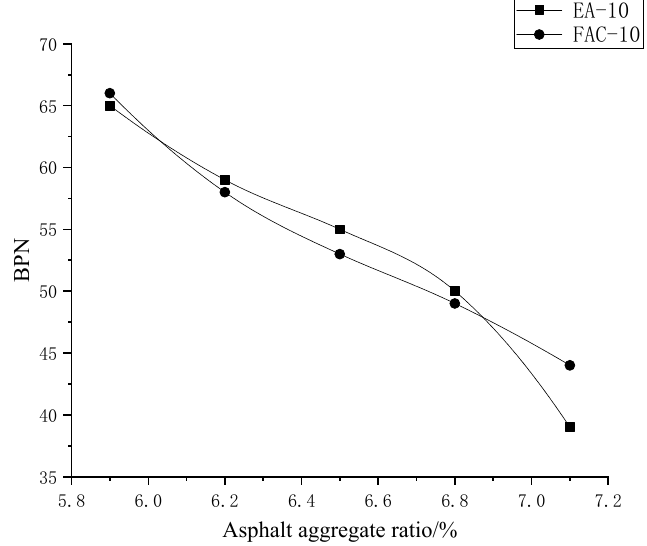
Figure 12. A plot of different asphalt aggregate ratio versus friction coefficient.